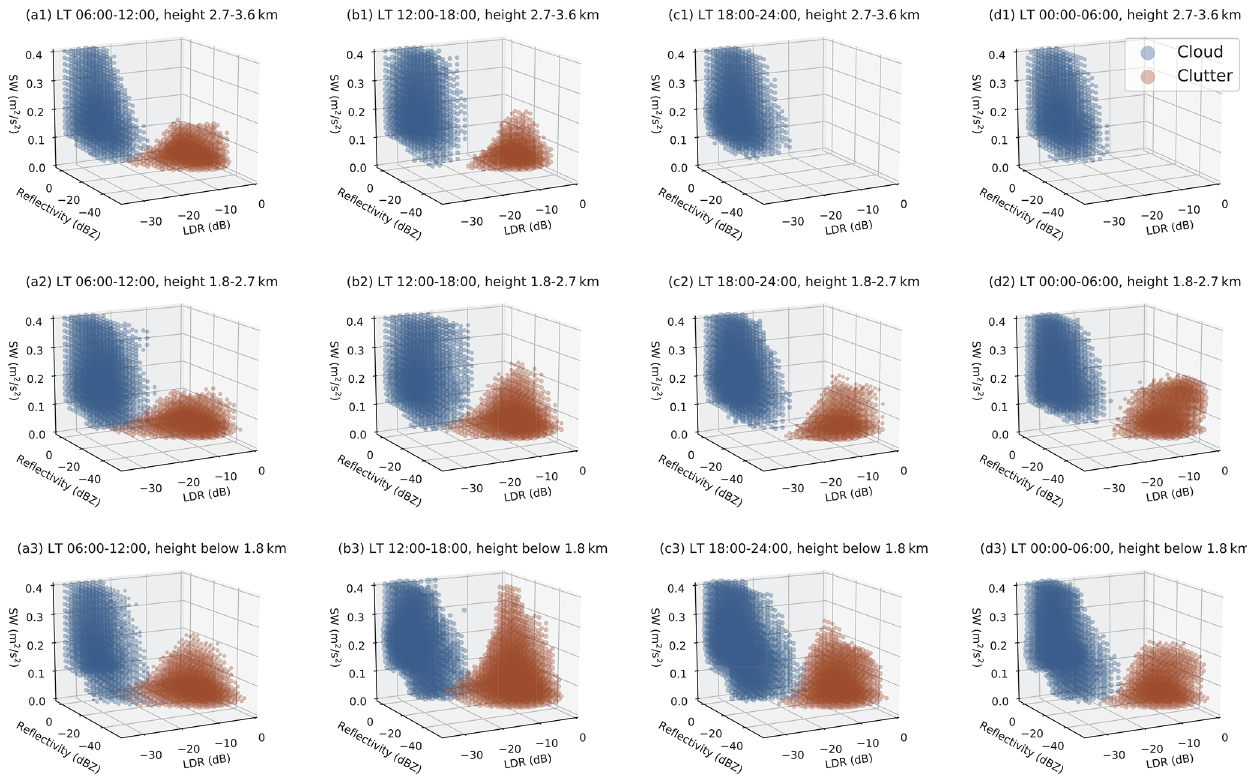
Figure 5. The multi-dimensional PDFs of clutter (brown dots) and cloud droplets (blue dots) at 06:00–12:00 (column a ), 12:00–18:00 (column b ), 18:00–24:00 (column c ), and 00:00–06:00LT (column d ), and height below 1.8km (row 3), 1.8–2.7km (row 2) and 2.7–3.6km (row 1) in the warm season (April to September). The size of dots represents the value of probability